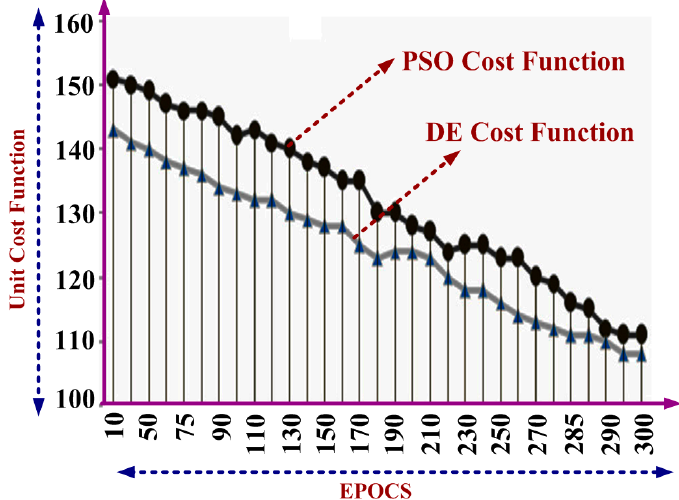
Figure 2. Cost Function Comparison for Particle Swarm Optimization (PSO) and Differential Evolution (DE).